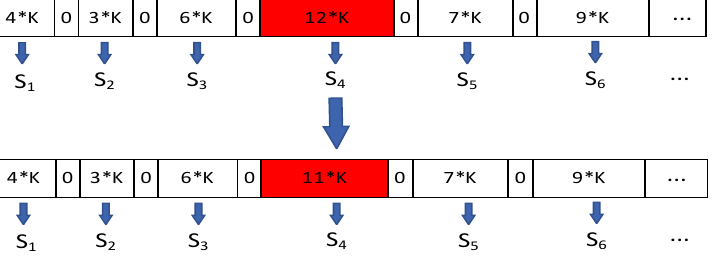
Figure 7. Mutation of tasks. It is achieved by distributing the load more evenly over the computation nodes by swapping satellites with high task load to the satellites with low load and swapping.